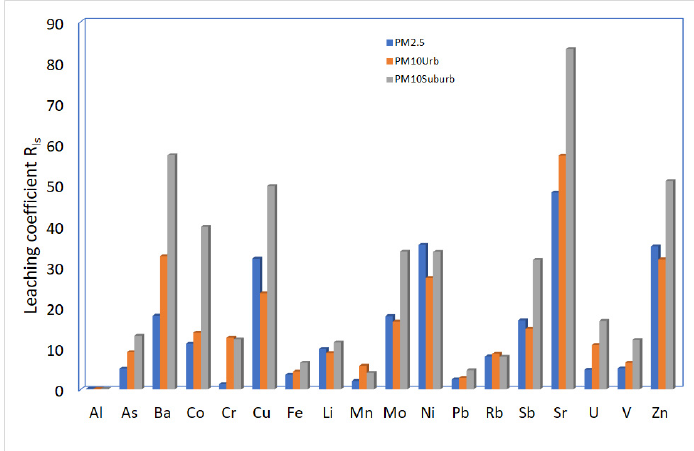
Figure 4. Distribution leaching coefficient, R ls , for metals and metalloids in each of the PM 10 and PM 2.5 size fractions.